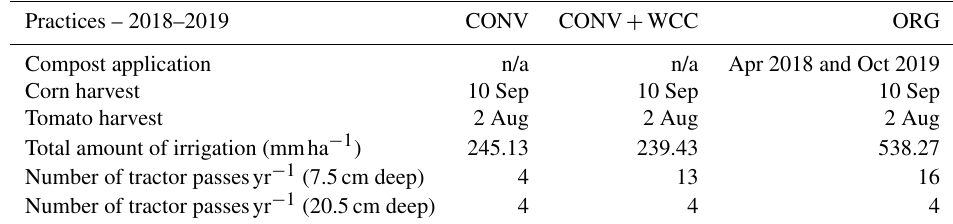
Table A5. Management summary for ORG, CONV + WCC, and CONV plots for the 2018–2019